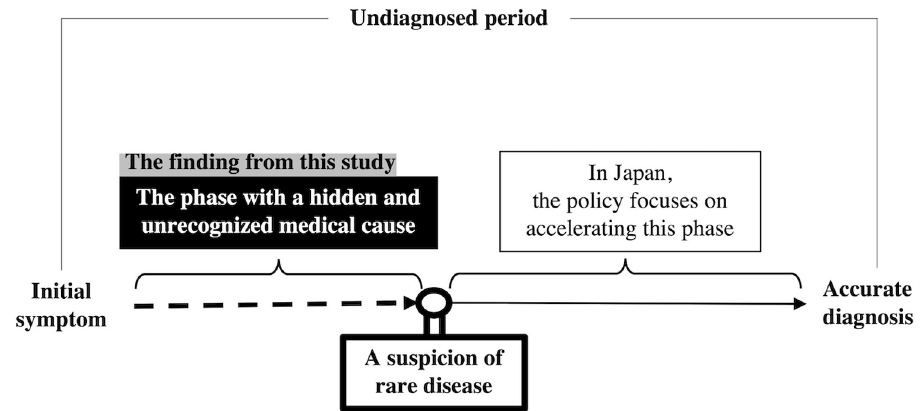
Fig 1. Diagram illustrating problems leading to delayed diagnosis of rare